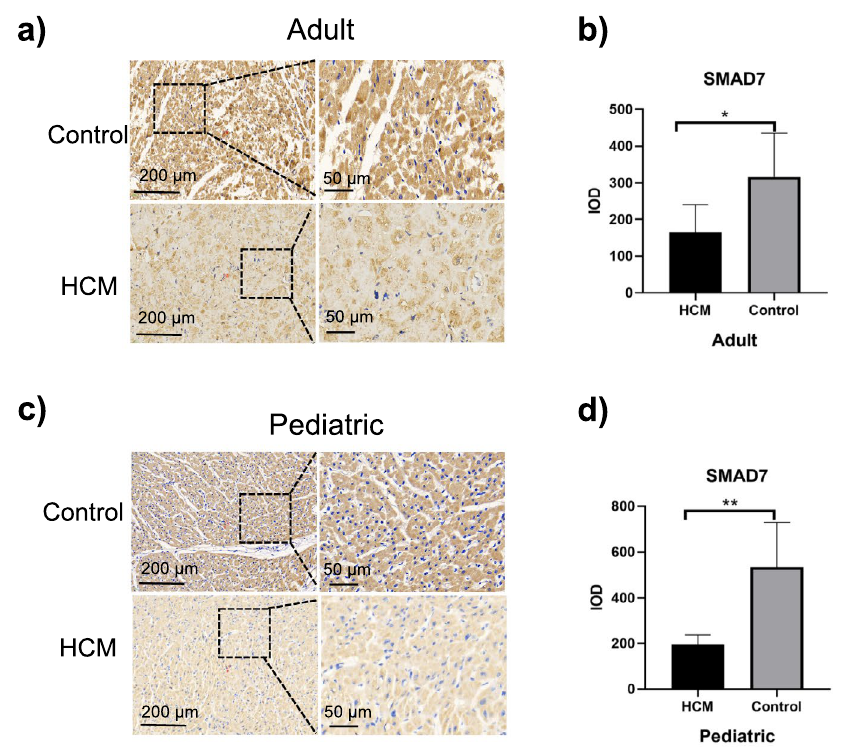
Figure 4. Immunohistochemical analysis of SMAD7 expression in ventricular septal myocardial tissue from patients with HOCM. ( a ) Representative images of immunohistochemical staining of SMAD7 in ventricular septal myocardial tissue from the control and adult HOCM patients. Scale bars, 200 μm and 50 μm (enlarged views of boxed areas). ( b ) Quantification of SMAD7 expression level in ventricular septal myocardial tissue from the control and adult HOCM patients. Data are mean ± SEM, * p < 0.05. ( c ) Representative images of immunohistochemical staining of SMAD7 in ventricular septal myocardial tissue from the control and pediatric HOCM patients. Scale bars, 200 μm and 50 μm (enlarged views of boxed areas). ( d ) Quantification of SMAD7 expression level in ventricular septal myocardial tissue from the control and pediatric HOCM patients. Data are mean ± SEM, ** p <